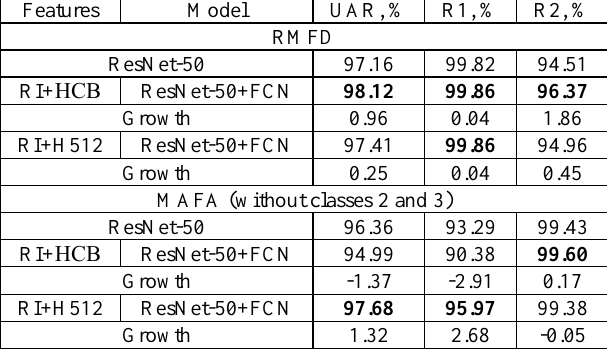
Table 4. Efficiency scores for cross-corpus analysis.